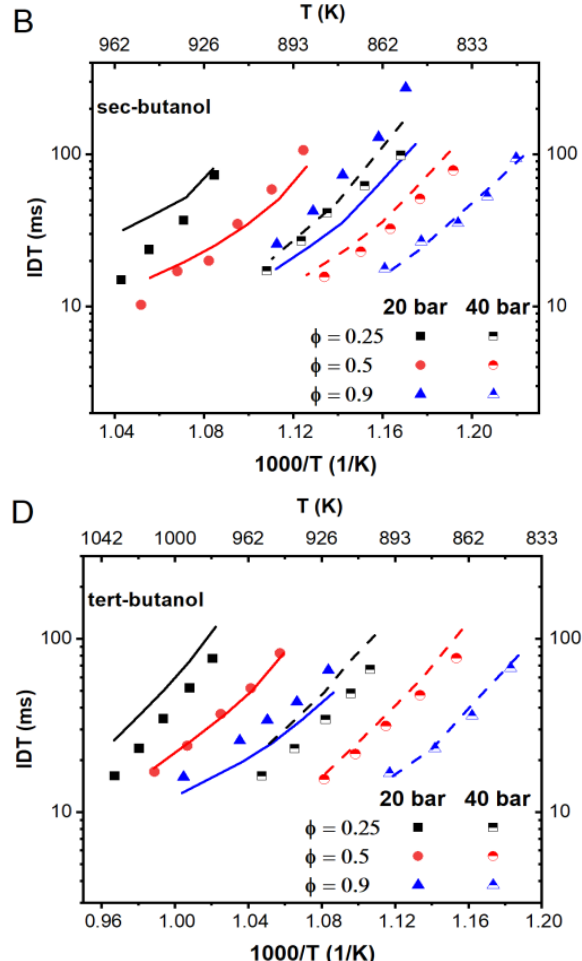
Figure 10. IDTs of ( A ) n-propanol and ( B ) iso-propanol measured in the RCM [39–41] at 20 and 40 bar and ϕ = 0.25, 0.5, and 0.9. (Symbols: experimental points; Lines: model predictions).